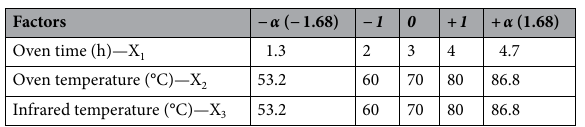
Table 3. Definition of the levels of the variables studied in the combined drying of gelatin.